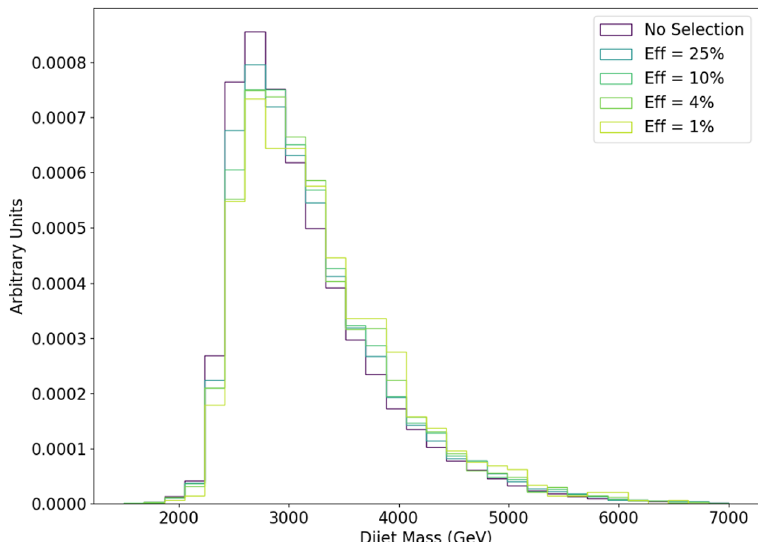
Figure 3 . The QCD dijet mass distribution after applying different selections on the TNT + M jj classifiers, trained with the 1% signal in the dataset. The QCD dijet mass distribution re- mains smooth even down to a selection efficiency of 1%, allowing the use of data-driven back- ground